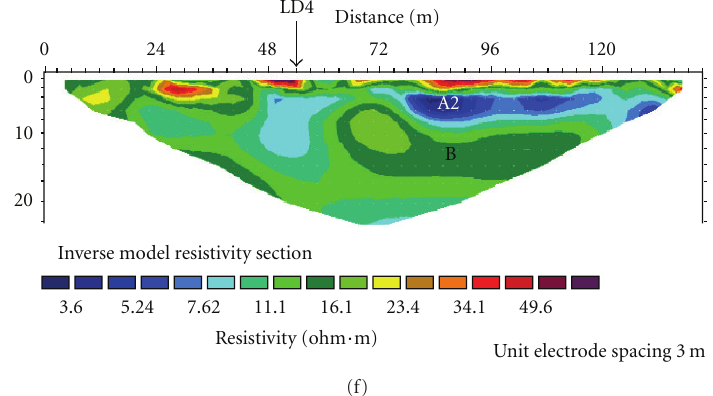
Figure 7: Seismic refraction profiles ((a), (c) and (e)) detect three layers, the first two (A1 and A2) related to Unit A and the third to Unit B drilled by boreholes; LV indicates low-velocity zones. Electrical resistivity tomography profiles ((b), (d) and (f)) detect four layers, the first two related to Unit A, the third to Unit B, and the fourth (C) to a non drilled shale layer. LD indicates lateral discontinuity of marl formation. Profile locations appear in Figure 5.